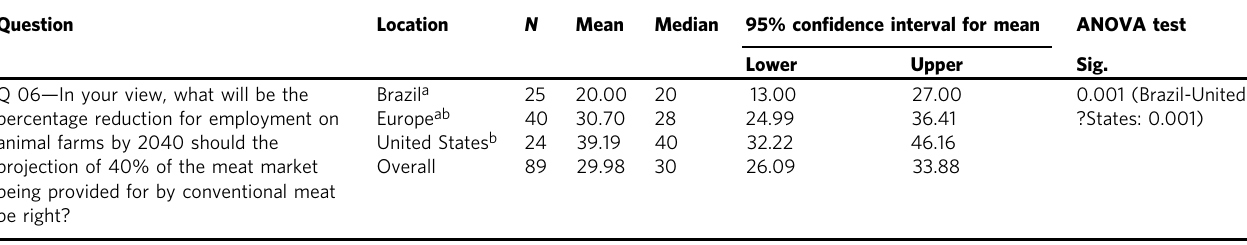
Table 5 Responses regarding the magnitude of the impact of alternative meat production on the number of jobs in the conventional meat industry by 2040 in Brazil ( N = 25), Europe ( N = 40) and the United States ( N = 23), using an open-ended question, as per interviews from August to October, 2021.